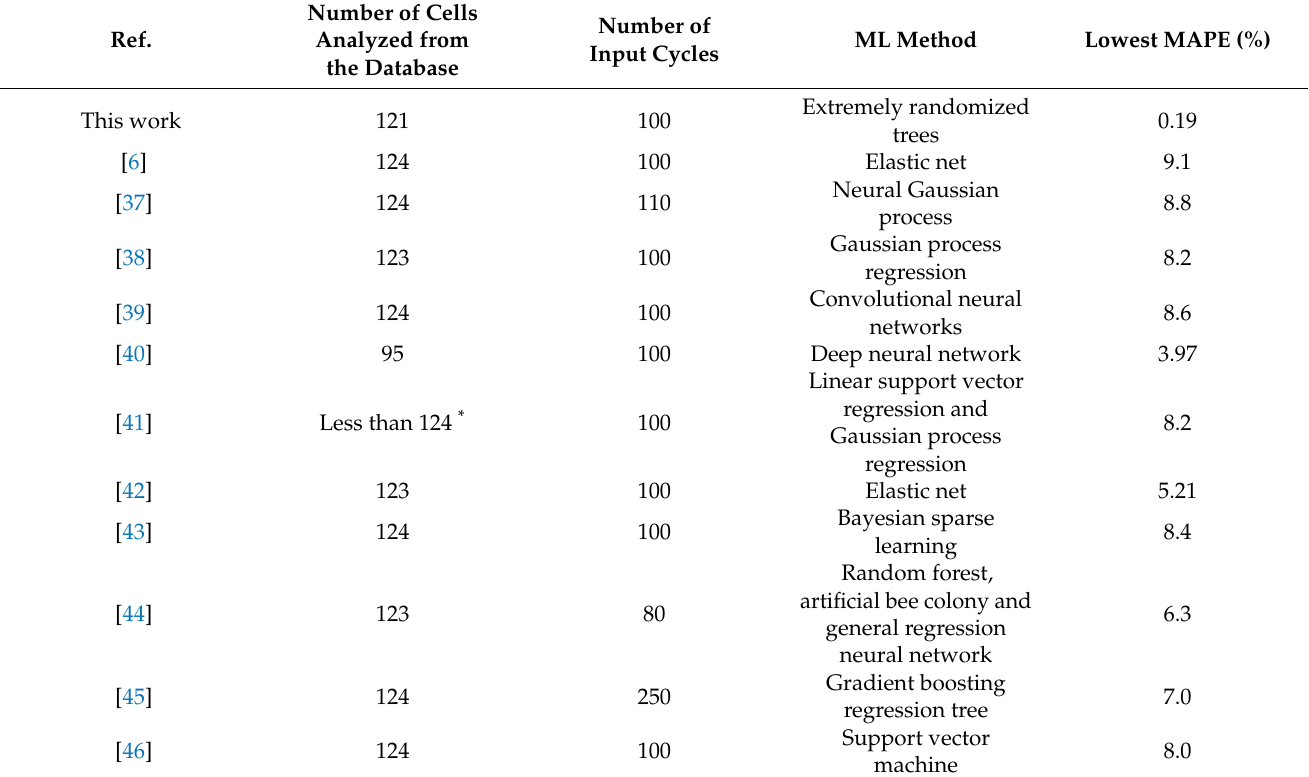
Table 3. Results for current work and comparable literature studies using the same